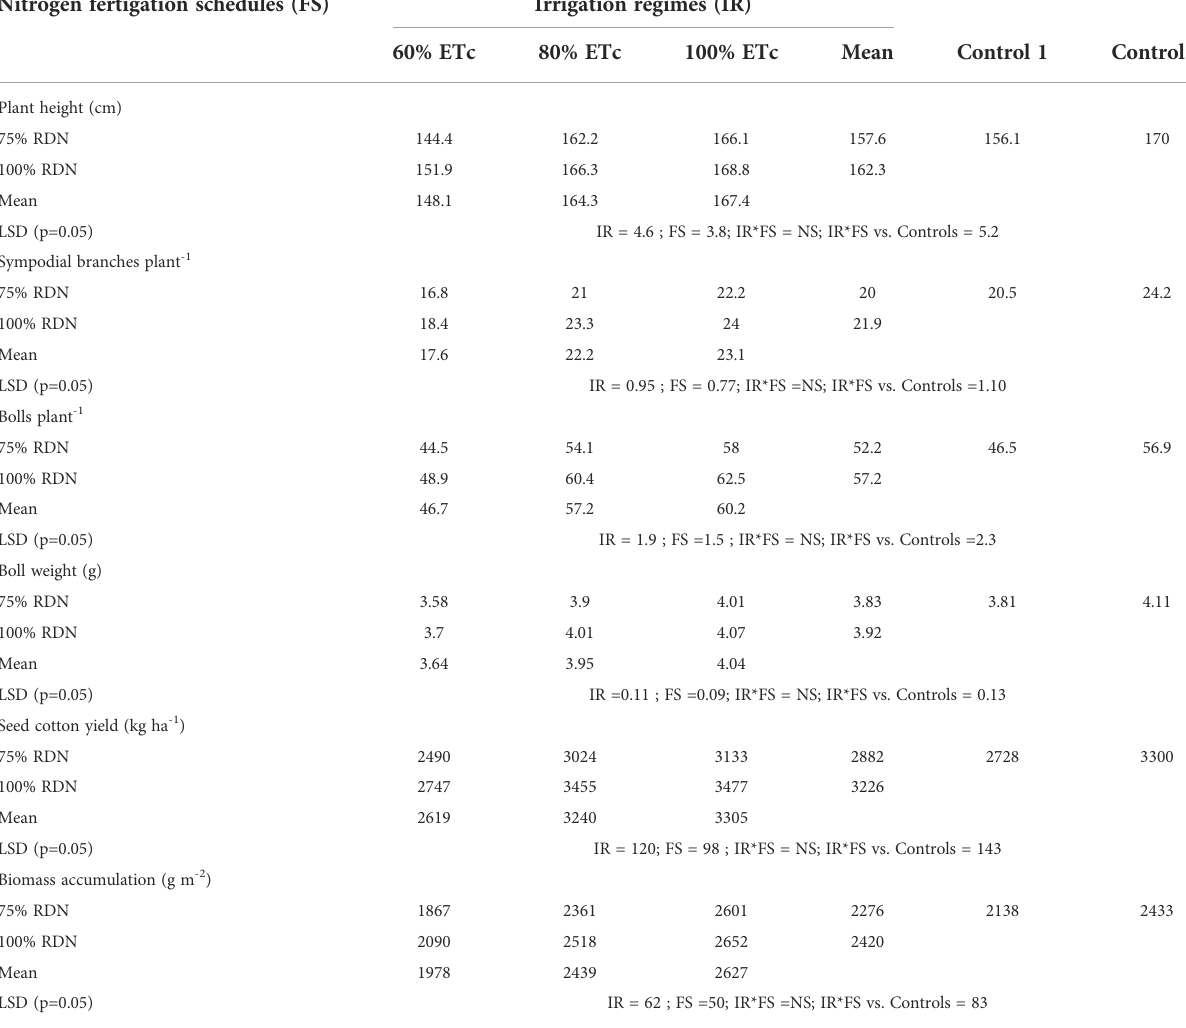
TABLE 5 Effect of various treatments on growth parameters, yield attributes, and seed cotton yield. Nitrogen fertigation schedules